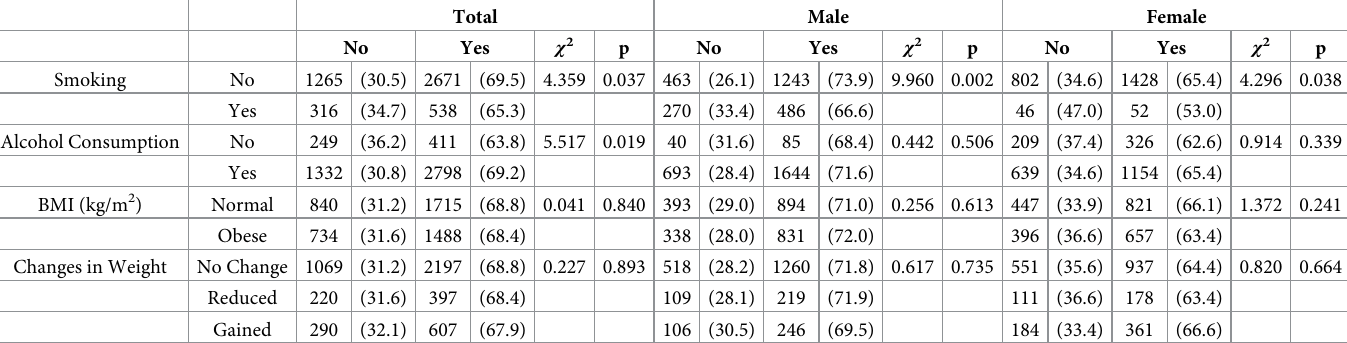
Table 3. Differences in regular workout habits based on health behaviors.